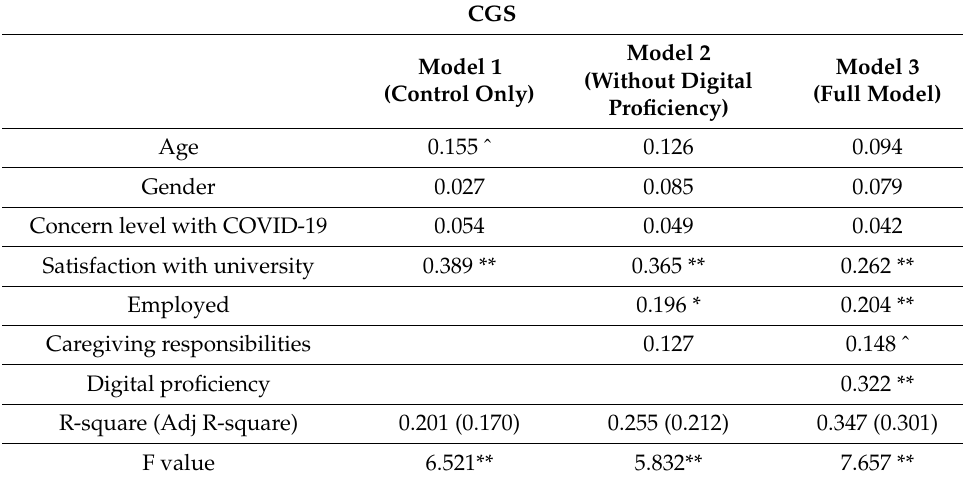
Table 3. Regression on psychological well-being